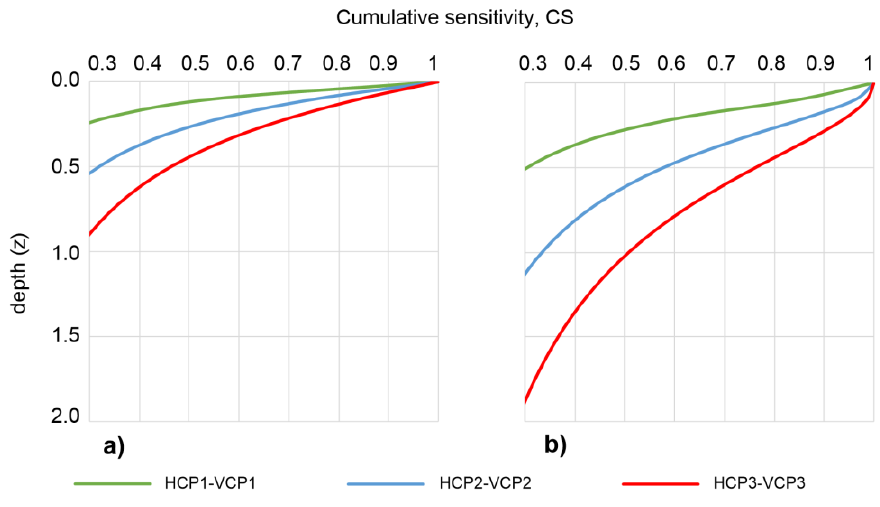
Figure 3. Cumulative sensitivity (CS) for three Mini-Explorer sensors: ( a ) VCP configuration and ( b ) HCP configuration coil.